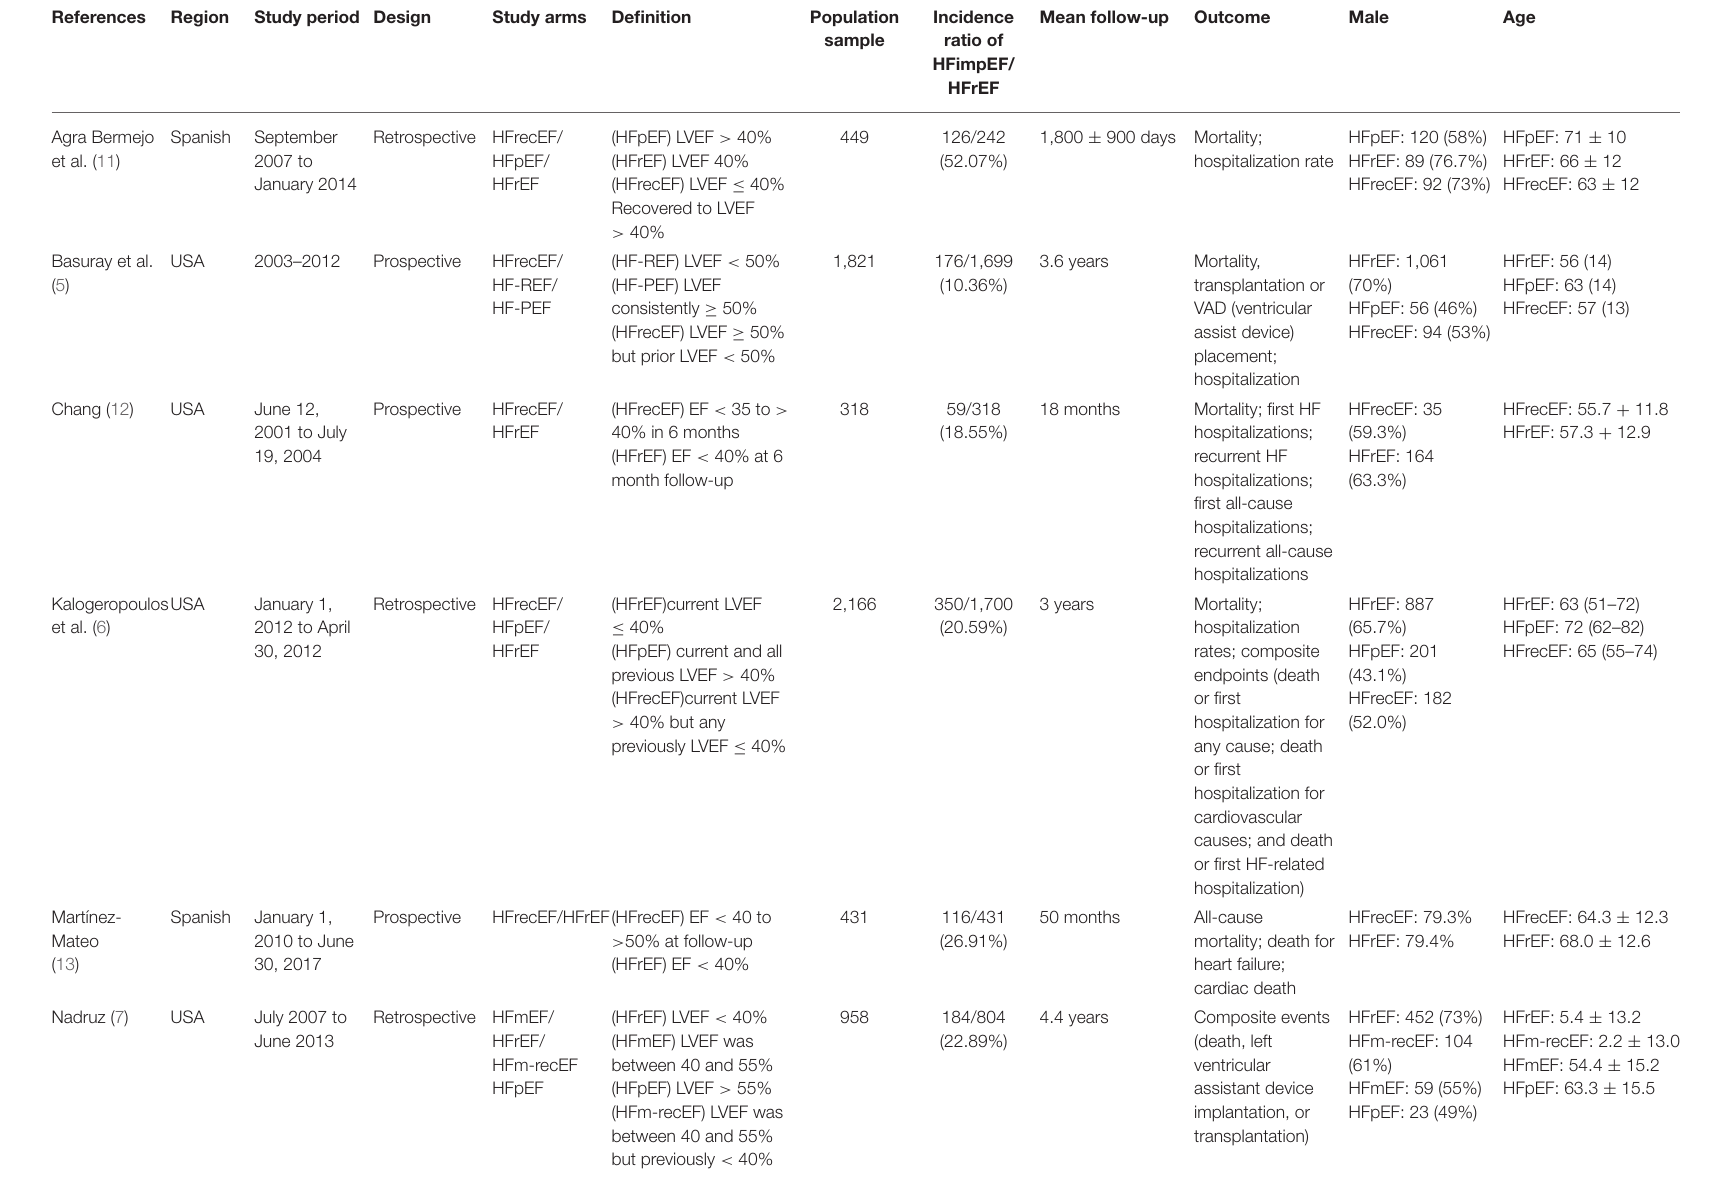
TABLE 1 | Baseline characteristic of included studies reporting heart failure patients with improved or recovered ejection